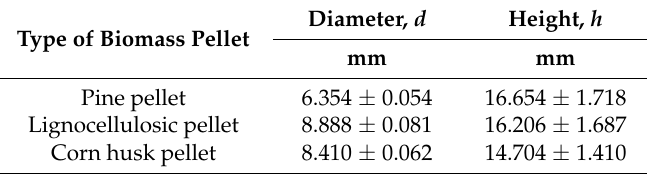
Table 2. Dimensions of reference pellets from biomass, mean ± standard deviation, n =